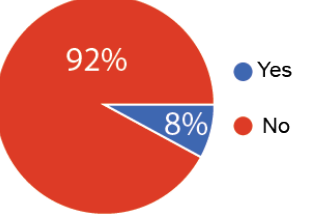
Figure 7. Percentage of students said that there is (not) a need for prior knowledge to attend the course.